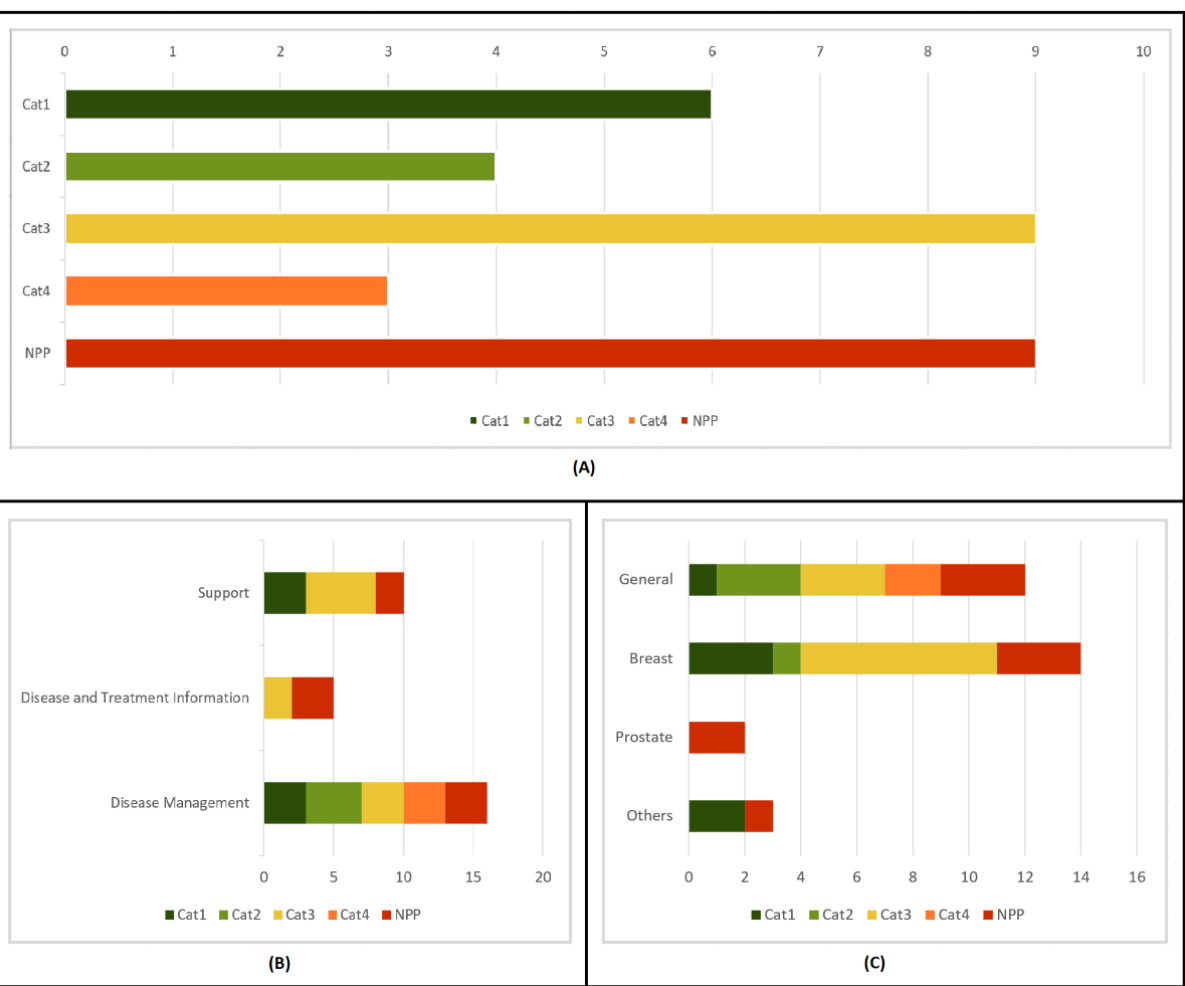
Figure 3. Privacy score summary